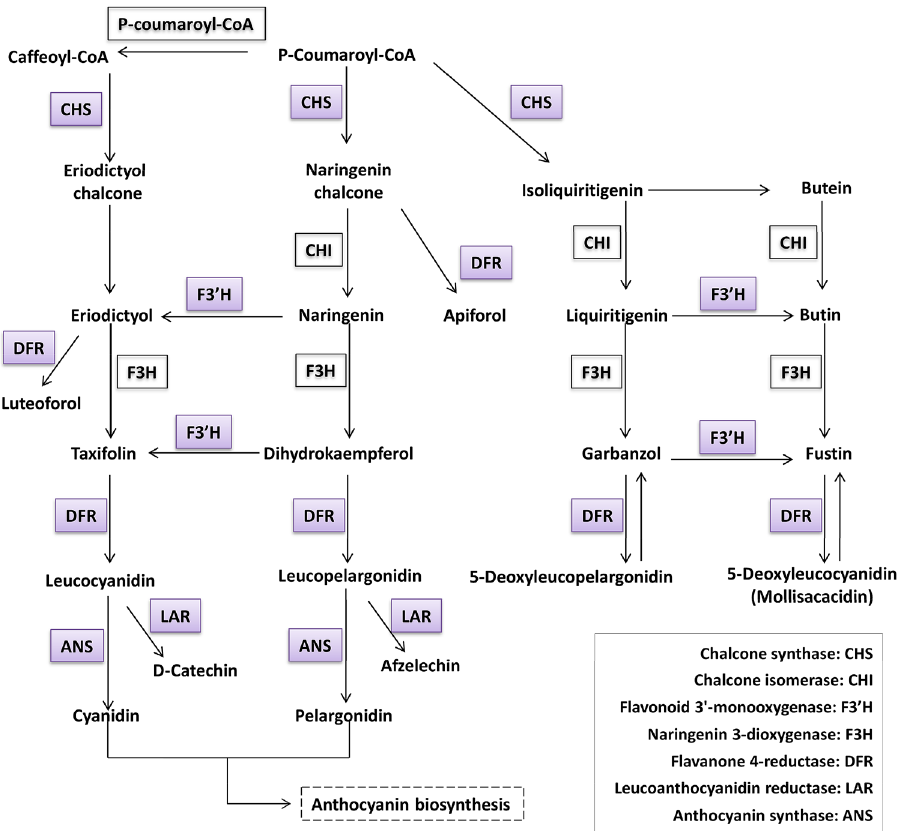
Figure 5. A putative flavonoid synthesis pathway, which was generated from the KEGG database based on the log 2 (fold change) values of identified differentially expressed genes. Colored boxes represent up-regulated genes. The symbols in boxes indicate the gene